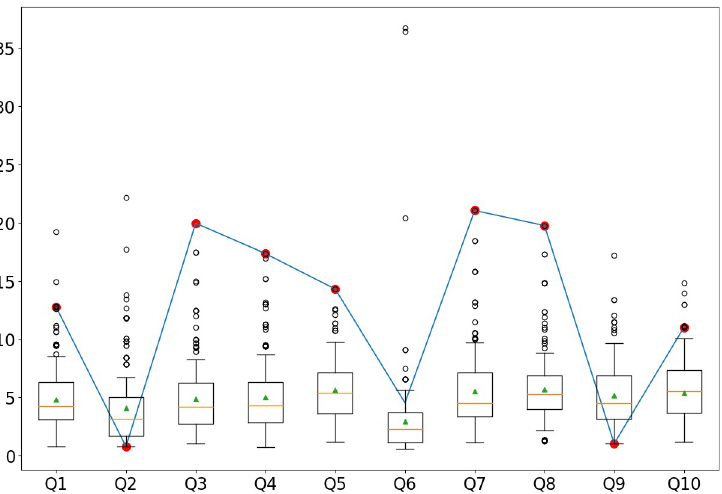
Fig 5. TF-IDF response values for participant 5 (dishonest responses) compared to the distributions of TF-IDF values of honest respondents in the CC dataset. The red dot indicates the items in which the participant faked. In this specific case, only Q6 received the same response in the honest and dishonest conditions. In this specific case, the algorithm accurately signaled seven of the nine dishonest responses. The total accuracy is 8/10. Two dishonest responses were